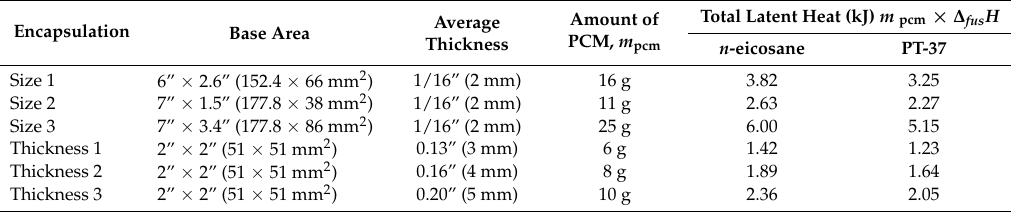
Table 2. Summary of dimensional attributes of encapsulations, amount of PCMs, and latent heat used.